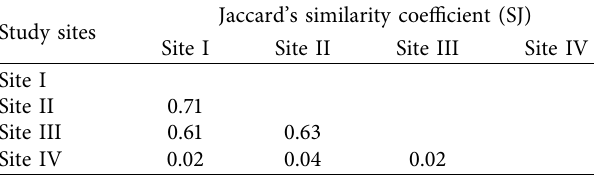
Table 6: Species composition similarity among study